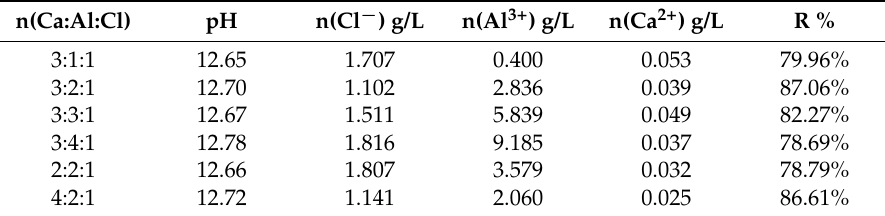
Table 2. Ion concentration of filtrates by ICP-MS analysis.